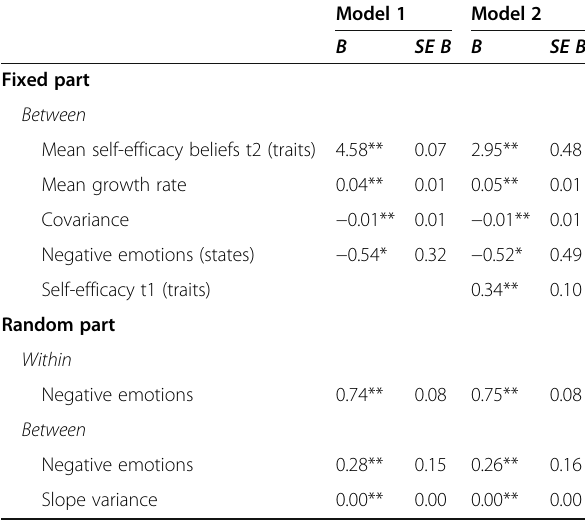
Table 4 Random slope model for pre-service teachers ’ self- efficacy beliefs (t2)